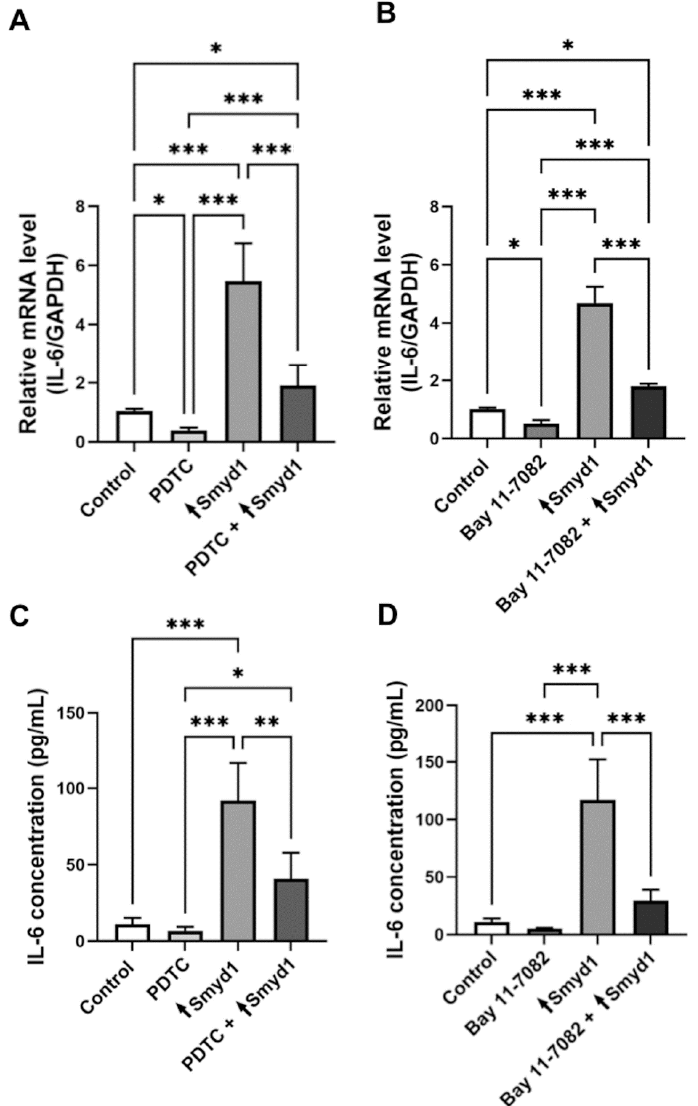
Figure 4. The inhibition of NF- κ B activity does not completely abolish the increase of Smyd1 expression in EA.hy926 cells. ( A , B ) RT-qPCR for the quantification of IL-6 mRNA levels in EA.hy926 cell lysates transfected with a pCMV2-Smyd1-flag vector ( ↑ Smyd1) and/or treated with the NF- κ B inhibitors PDTC (10 µ M) ( A ) or Bay 11-7082 (10 µ M) ( B ). Expression values relative to the untreated control cell extracts n = 3, * p < 0.05, *** p < 0.001 using two-way ANOVA. ( C , D ) ELISA for the quantification of IL-6 concentrations in supernatants of EA.hy926 cells transfected with the pCMV2- Smyd1-flag vector ( ↑ Smyd1) and/or treated with PDTC (10 µ M) ( C ) or Bay 11-7082 (10 µ M) ( D ). n = 3, * p < 0.05, ** p < 0.01, *** p < 0.001 using two-way ANOVA. All graphs reported as mean ± SD. 3.5. The Methyltransferase Activity of Smyd1 Is Involved in the Regulation of IL-6 Expression To investigate whether the methyltransferase activity of Smyd1 is involved in the regulation of IL-6 expression, EA.hy926 cells were transfected with a vector containing a gene insert that encodes a Smyd1 variant without methyltransferase activity due to a point mutation within the SET domain (Figures 5A,B and S1J). In contrast to the active Smyd1-overexpressing EA.hy926 cells, this methyltransferase-inactive mutant had only a non-significant ( p ≥ 0.05) impact on IL-6 expression, both at the mRNA level (Figure 5C) and the amount of secreted IL-6 (Figure 5D). Similar results were obtained for cells that were simultaneously Smyd1-transfected and LPS-stimulated (Figure